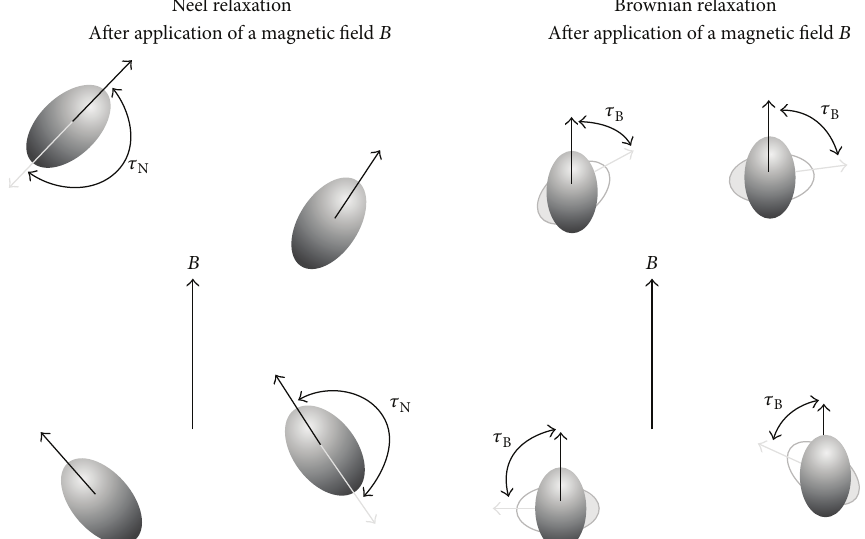
Figure 19: The schematic of magnetic relaxation mechanisms such as Neel and Brownian relaxation mechanisms [90].